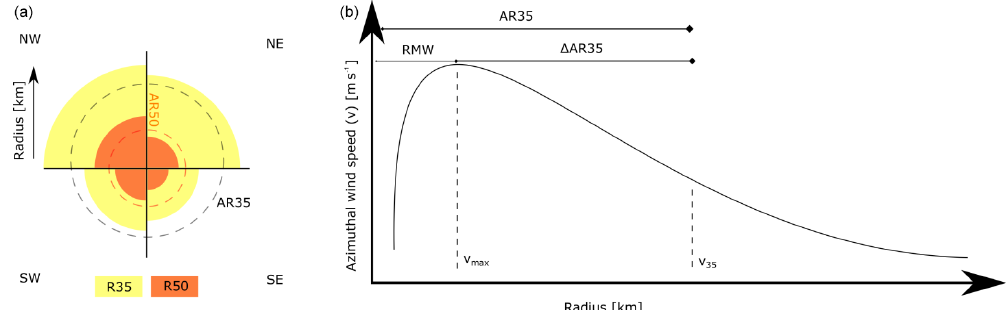
Figure 1. Sketch of the terminology used in this paper. (a) The difference in wind radii for several wind values observed from different quadrants (NW, NE, SE, SW) and the average (AR) are shown. (b) RMW, AR35 and (cid:49) AR35 are